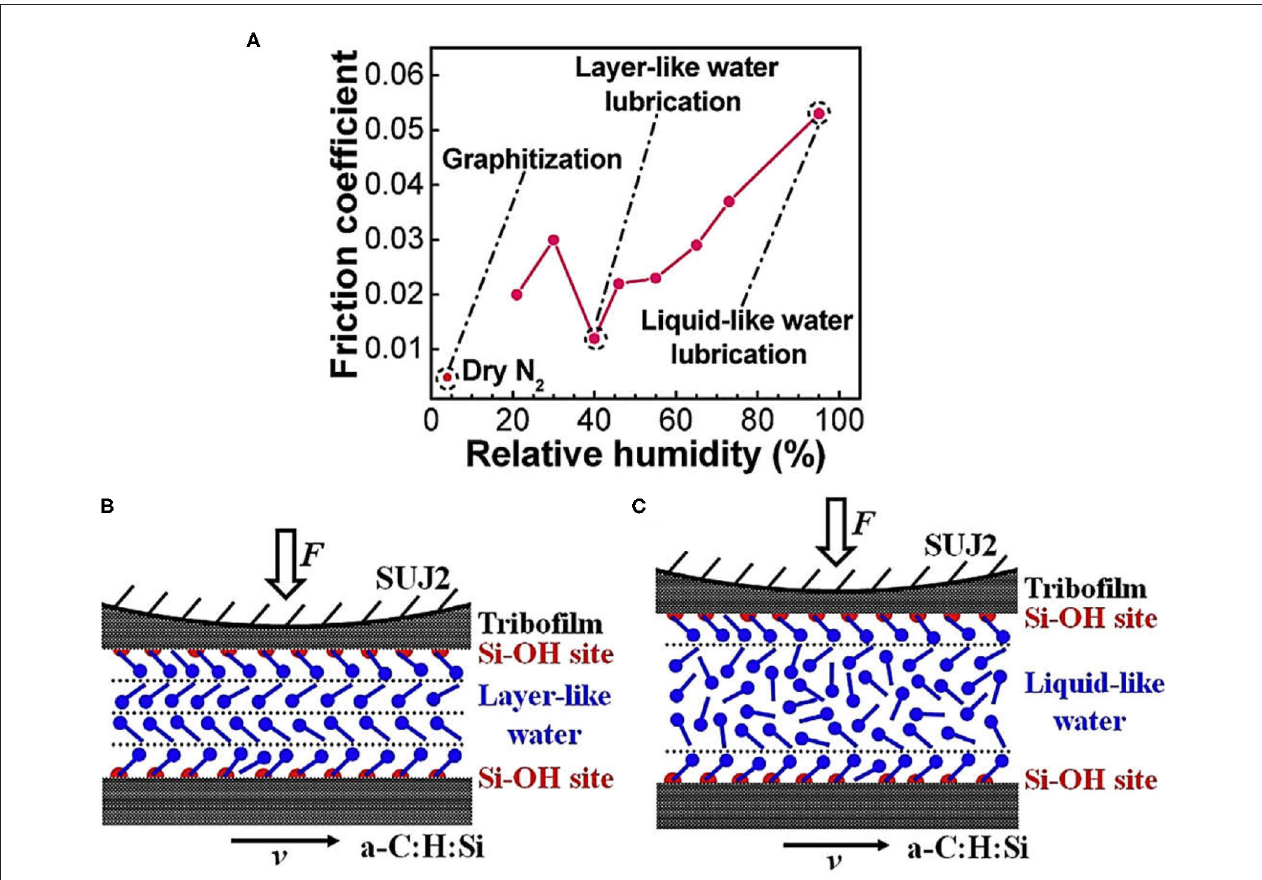
FIGURE 5 | Friction coefficient of a-C:H:Si under different humidities (A) and its lubricating mechanism: (B) layer-like water absorption on the hydroxylated surfaces at moderate relative humidity and (C) liquid-like water absorption under high relative humidity. Adapted with permission from Chen et al. (2013) Copyright 2013, IOP Publishing